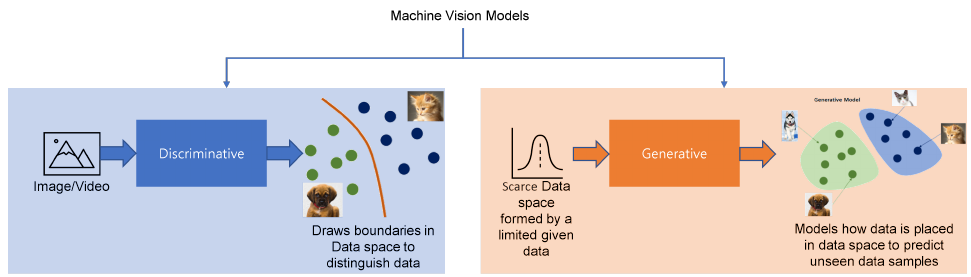
Figure 3. A high-level division of the deep learning vision models based on output type highlights the difference between